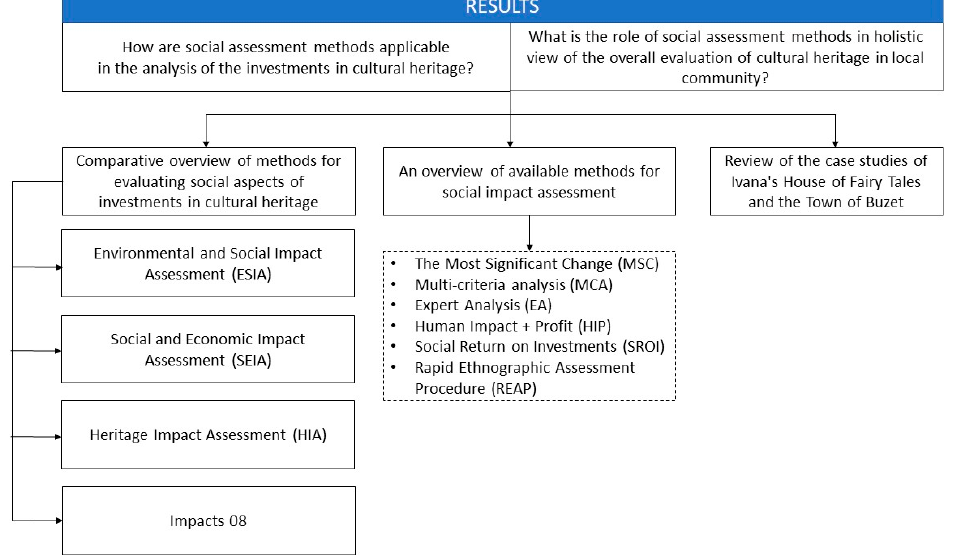
Figure 4. A flow chart summarizing the results path. Source: